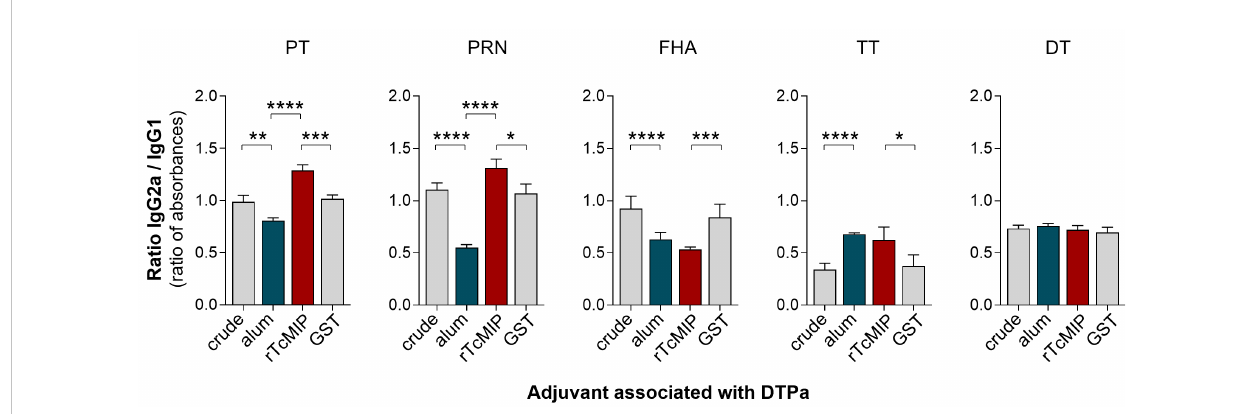
FIGURE 8 Ratio of IgG2a to IgG1 antibody levels in neonatal mice immunized with DTPa adjuvanted by rTcMIP. Neonatal Balb/c mice received at days 7 and 28 of life, injections of 125 µL DTPa either unadjuvanted ( “ crude ” , n=20) or adjuvanted with alum (n=25), with rTcMIP (n=25) or with GST (n=15) (cf. M&M). Ab